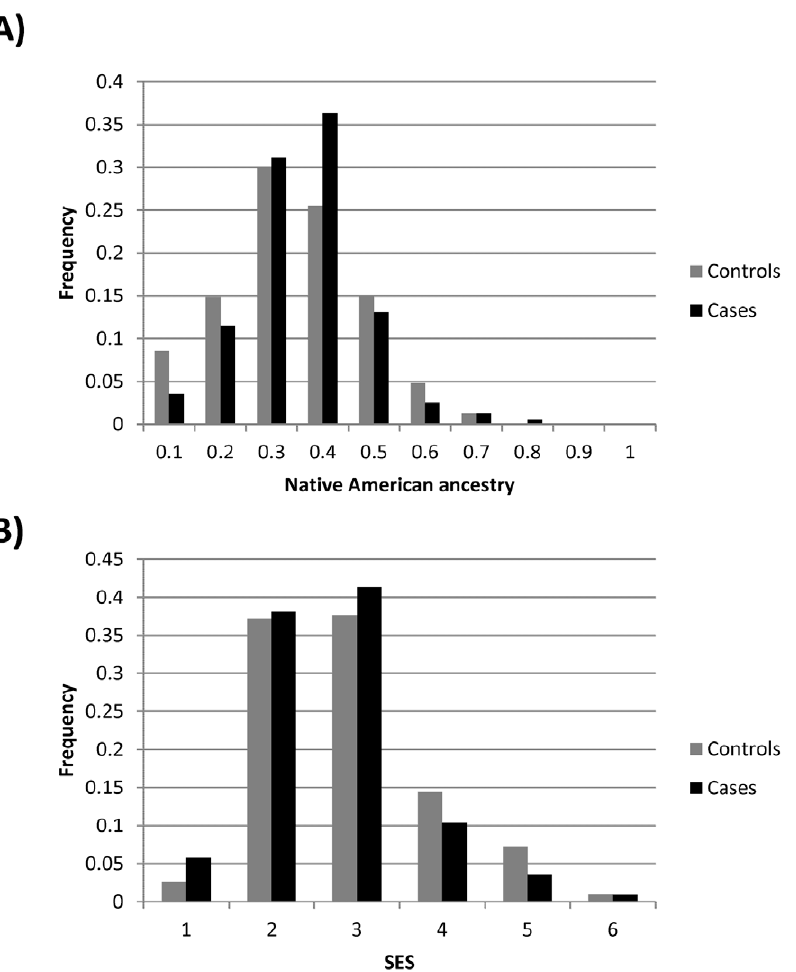
Figure 1. Distribution of (A) Native American ancestry and (B) socioeconomic status (bands 1 to 6) in Antioquian T2D cases and controls.